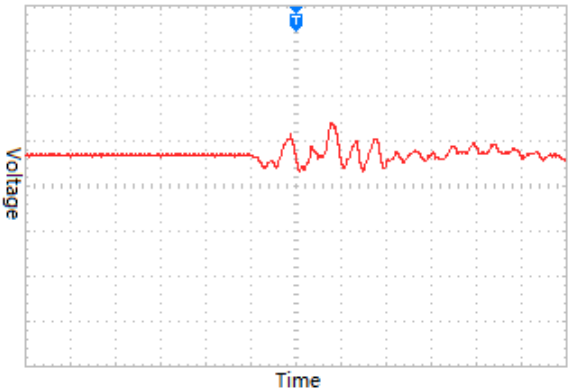
Figure 11. Restrained interference signal of second grid.